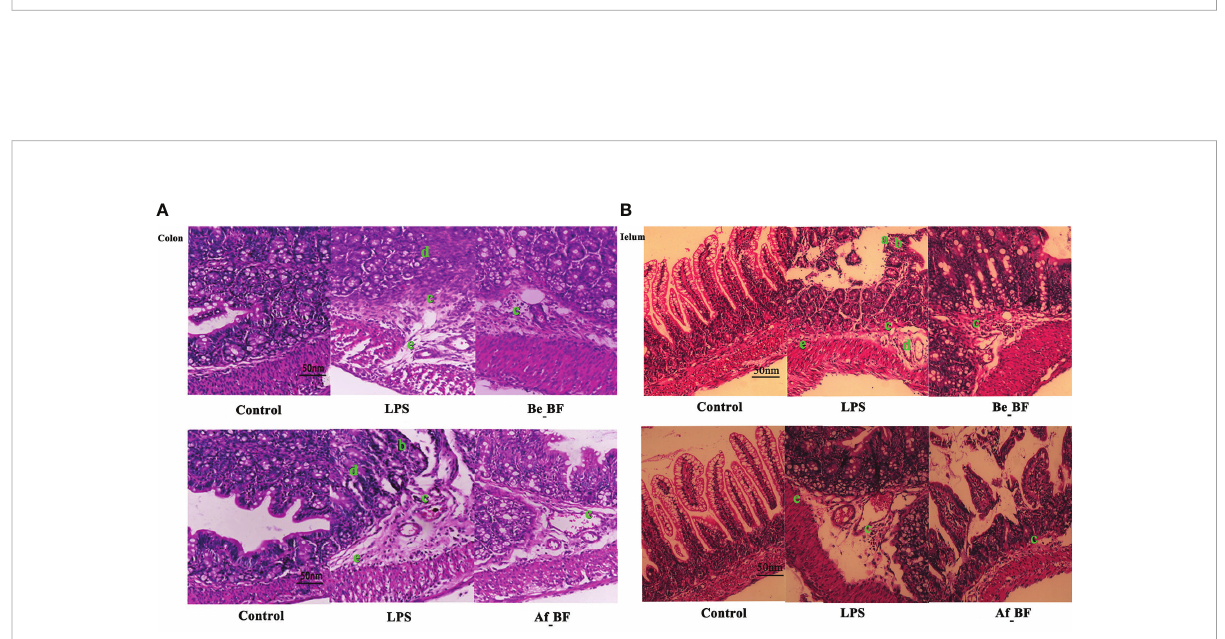
FIGURE 5 The effect of B . fragilis on the prevention and treatment of rat colon (A) and ileum (B) induced by C . malonaticus LPS. (A, B) Slight damage to villus tips (A) ; distension and separation of lamina propria (B) ; in fl ammatory cytokine in fi ltrates (C) ; intestinal structure disorder (D) ; edema in mucosa layers and submucosa (E) . LPS, LPS-treated group; Be_BF, B . fragilis treatment before injection of LPS; Af_BF, B . fragilis treatment after injection of